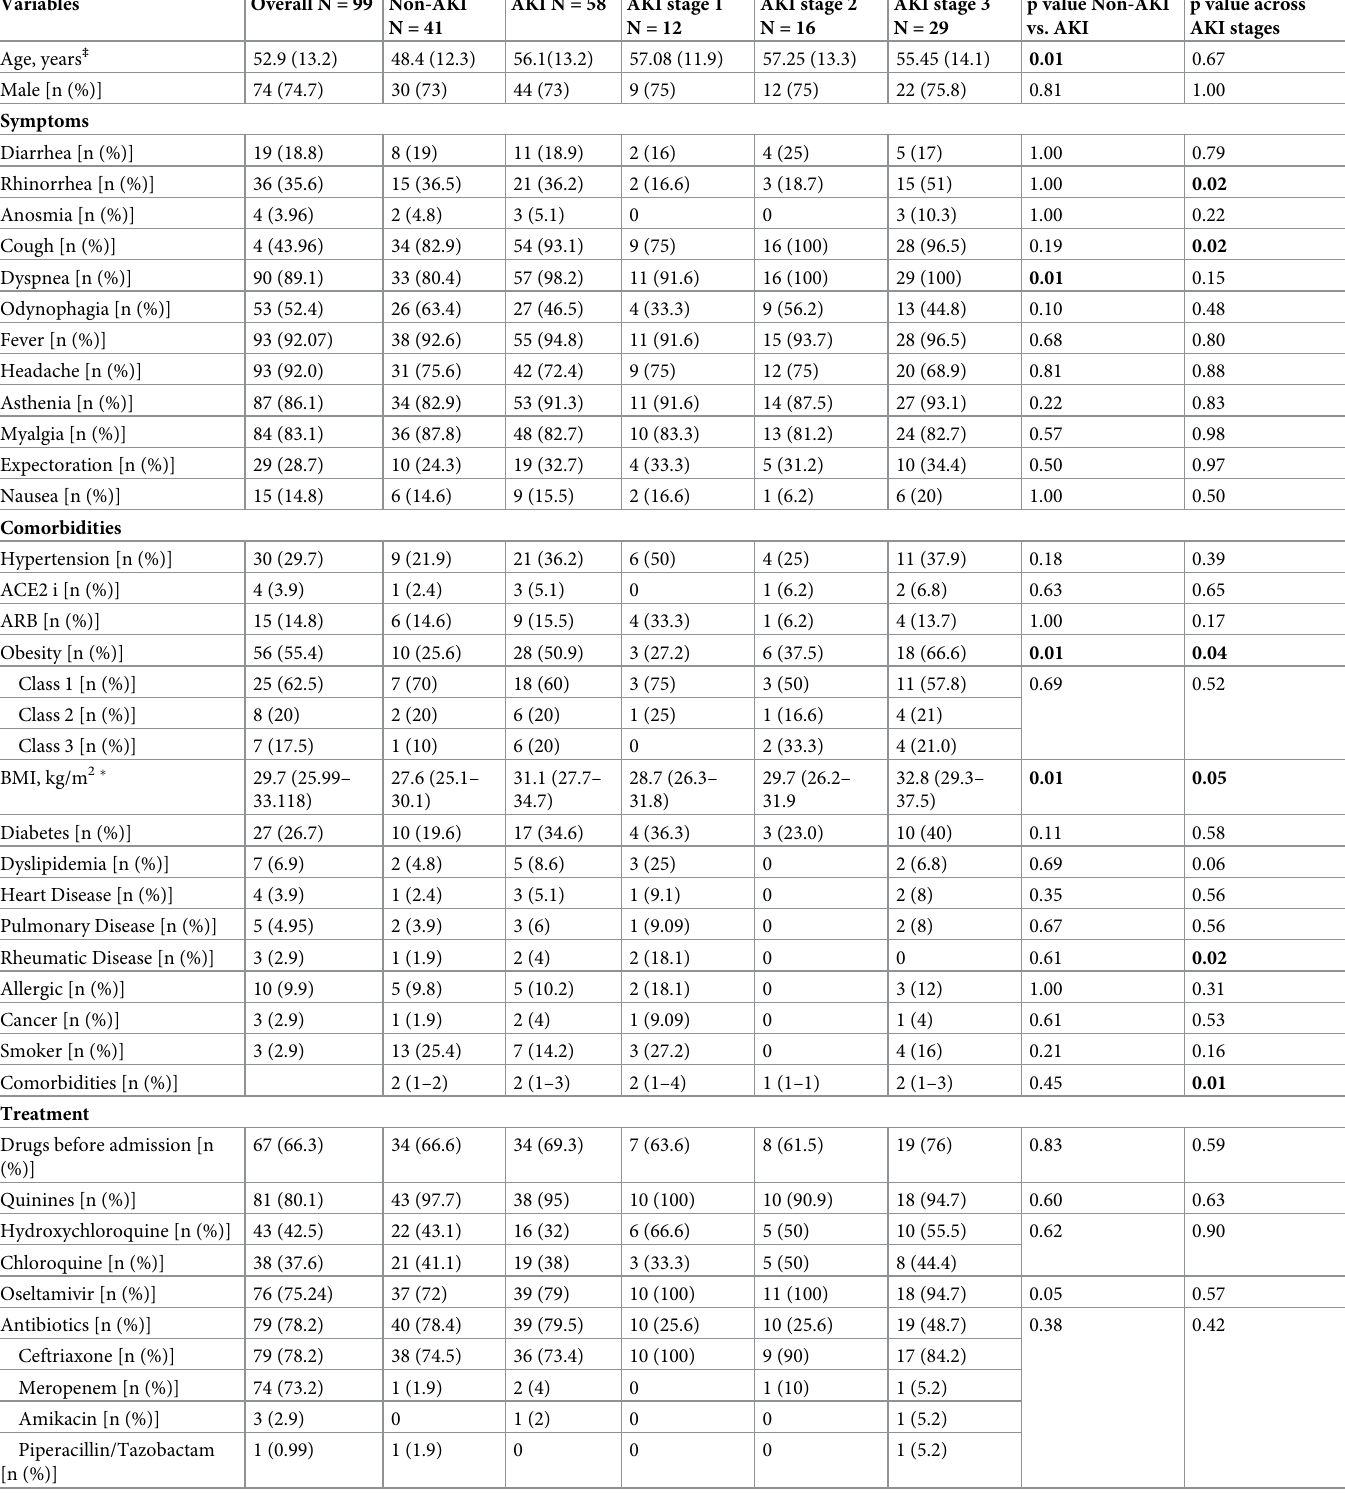
Table 1. Baseline characteristics of the study